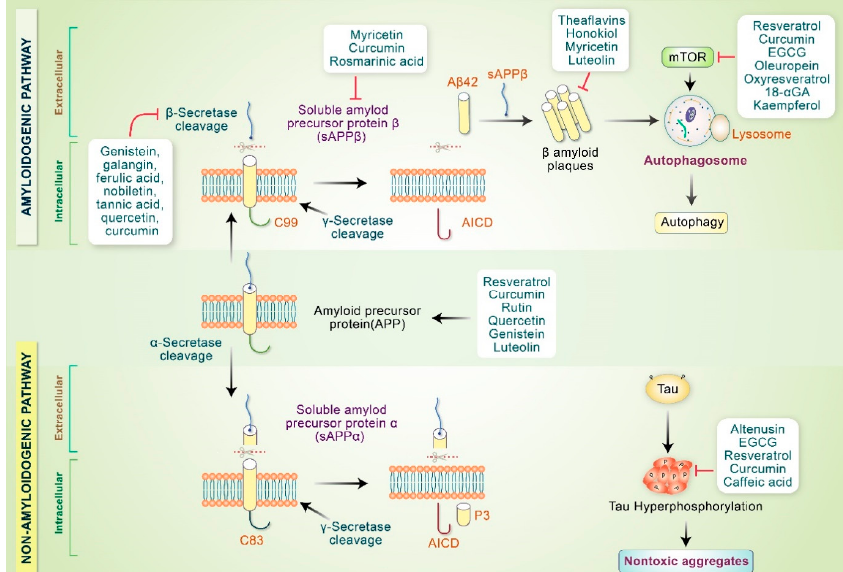
Figure 3. Phytochemicals modulate AD pathogenesis. Phytochemicals stimulate α -secretase activity or may hinder β - secretase activity that inhibits toxic oligomer production. Polyphenols and other compounds modify A β aggregates and convert them into nontoxic oligomers. Some phytochemicals inactivate mTOR and initiate the autophagy pathway. Polyphenols and other compounds prevent tau hyperphosphorylation and convert tau aggregates into nontoxic aggregates.